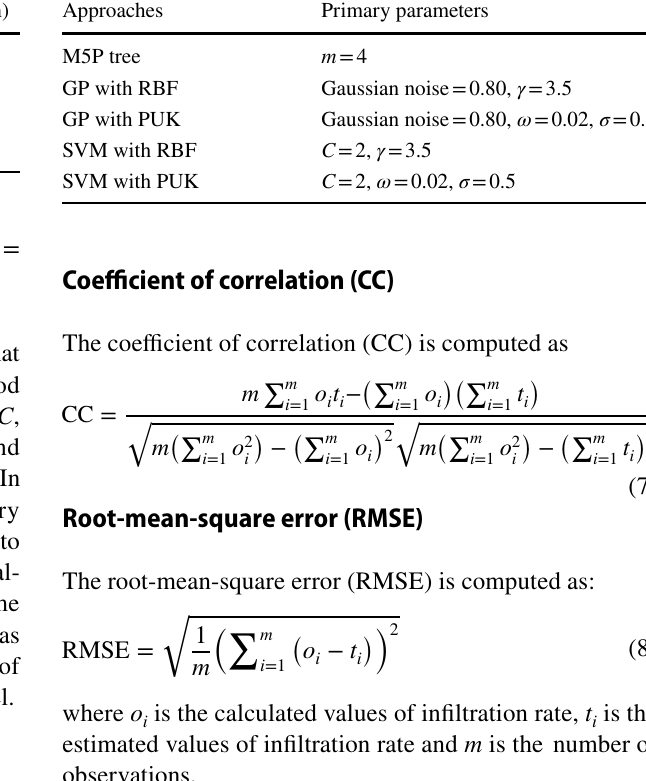
Table 3 Correlation matrix of input data set Variables